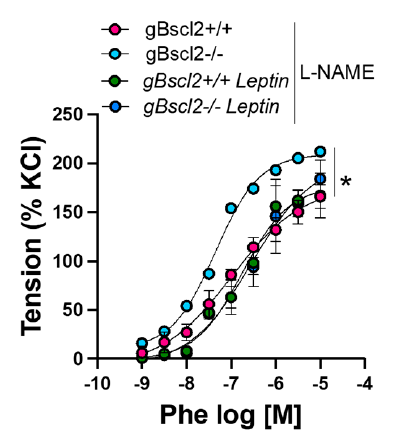
Figure 4. Leptin improves vascular adrenergic contractility in arteries from wild-type mice by regulating nitric oxide bioavailability. Concentration response curves to phenylephrine in aortic rings from wild-type (gBscl2 +/+ ) and Bscl2 deficient mice (gBscl2 -/- ) treated with, or without, leptin (0.3 mg/Kg/day for 1 week, via osmotic mini-pump), and in the presence or absence of N-nitro-l-arginine methyl ester [L-NAME; (100 µ mol/L)]. Data are presented as mean ± S.E.M. N = 4–6. * p < 0.05 gBscl2 +/+ vs. gBscl2 -/- and gBscl2 -/- + L-NAME pre-incubation.